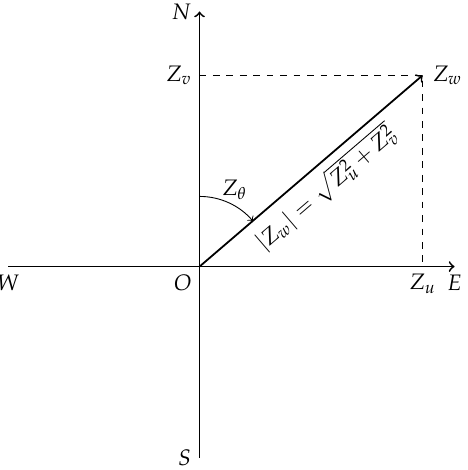
Figure 3. Wind vector Z w and components U-wind and V-wind.